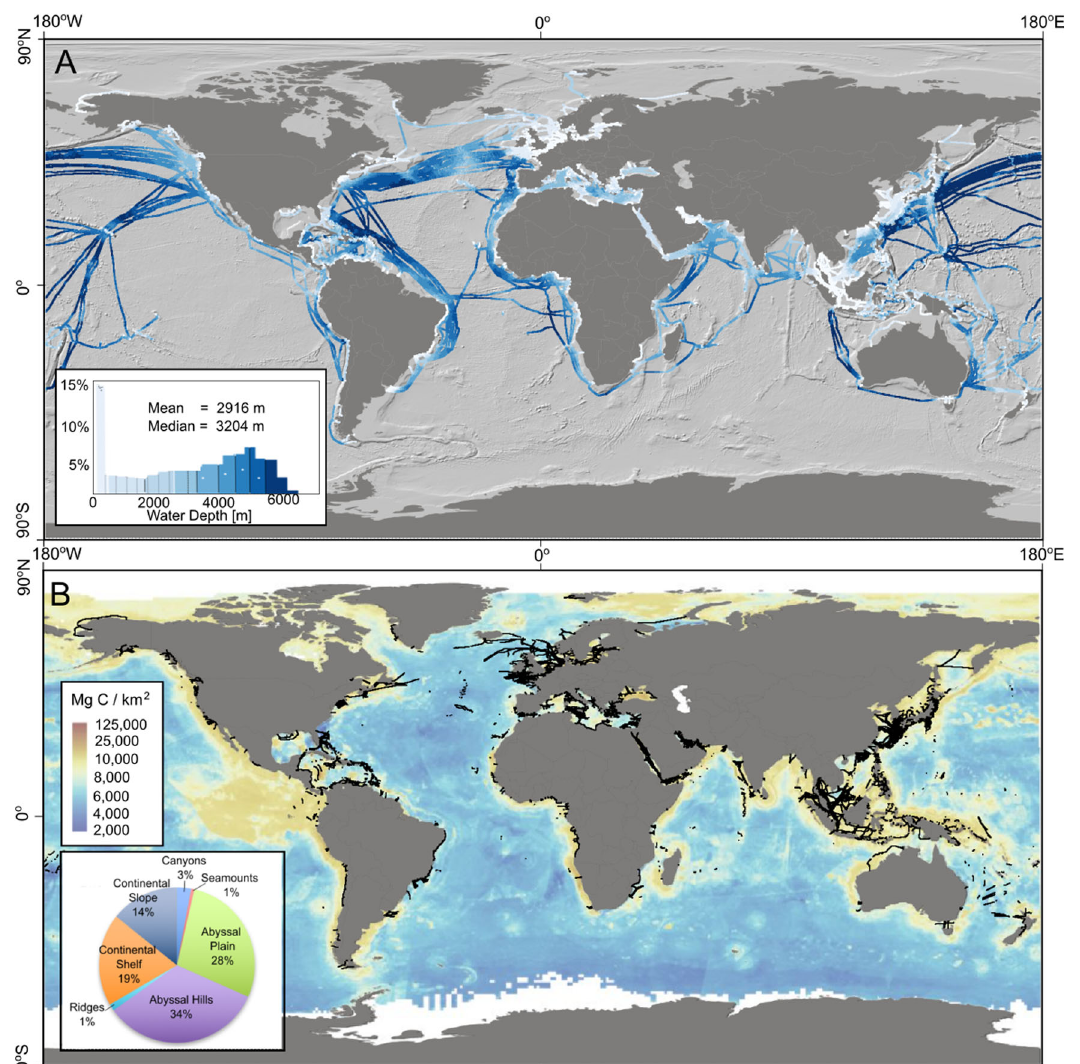
Fig. 1 | Extent of submarine telecommunications cables across the ocean and sea fl oor sedimentary carbon stocks. A Cable routes are colour coded (white to dark blue) according to water depth (m). Bathymetry derived from the GEBCO_2022 Grid, GEBCO Compilation Group (2022) GEBCO 2022 Grid. B Extent ofcableroutesinwaterdepthsofupto2000millustratedasblacklines,overlying